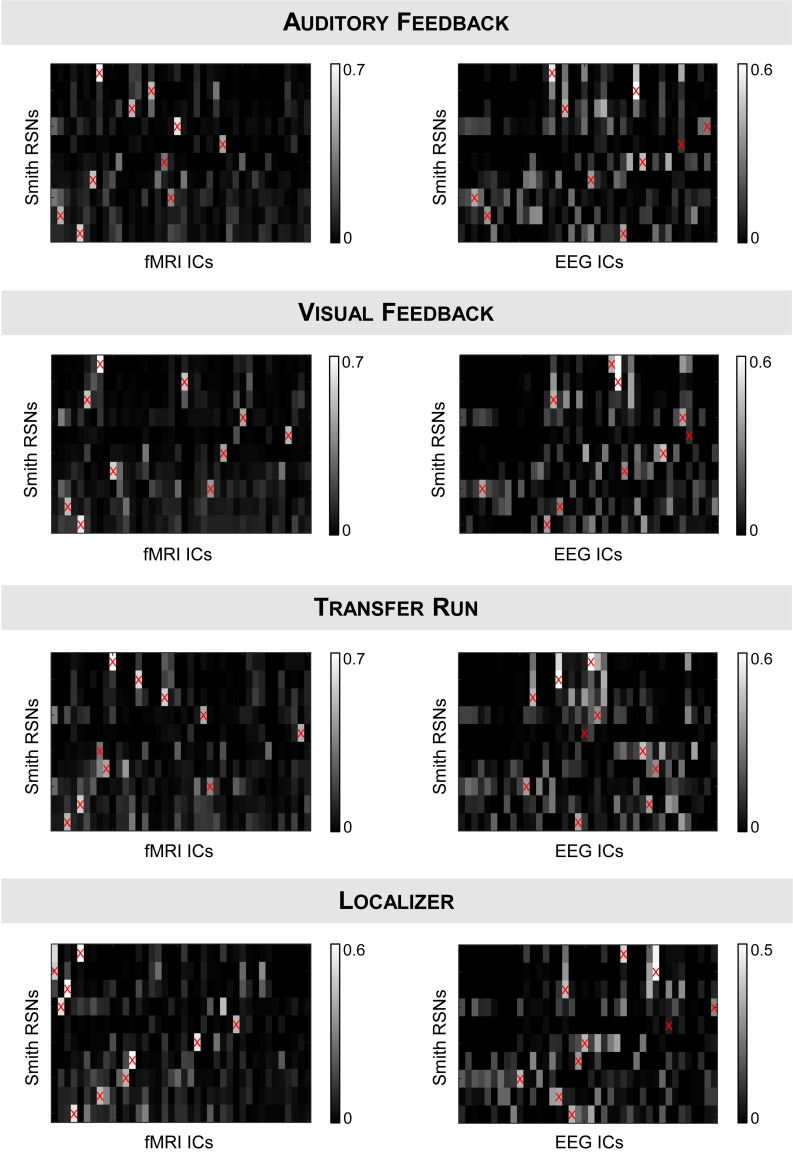
Dice coefficients between all possible combinations of (left) fMRI ICs or (right) EEG-ESI ICs (x-axis) and the RSN templates (y-axis) from Smith et al. (2009), for the (from top to bottom) auditory feedback, visual feedback, transfer, and localizer runs. fMRI/EEG-ESI ICs assigned to RSN templates are marked by a red cross.